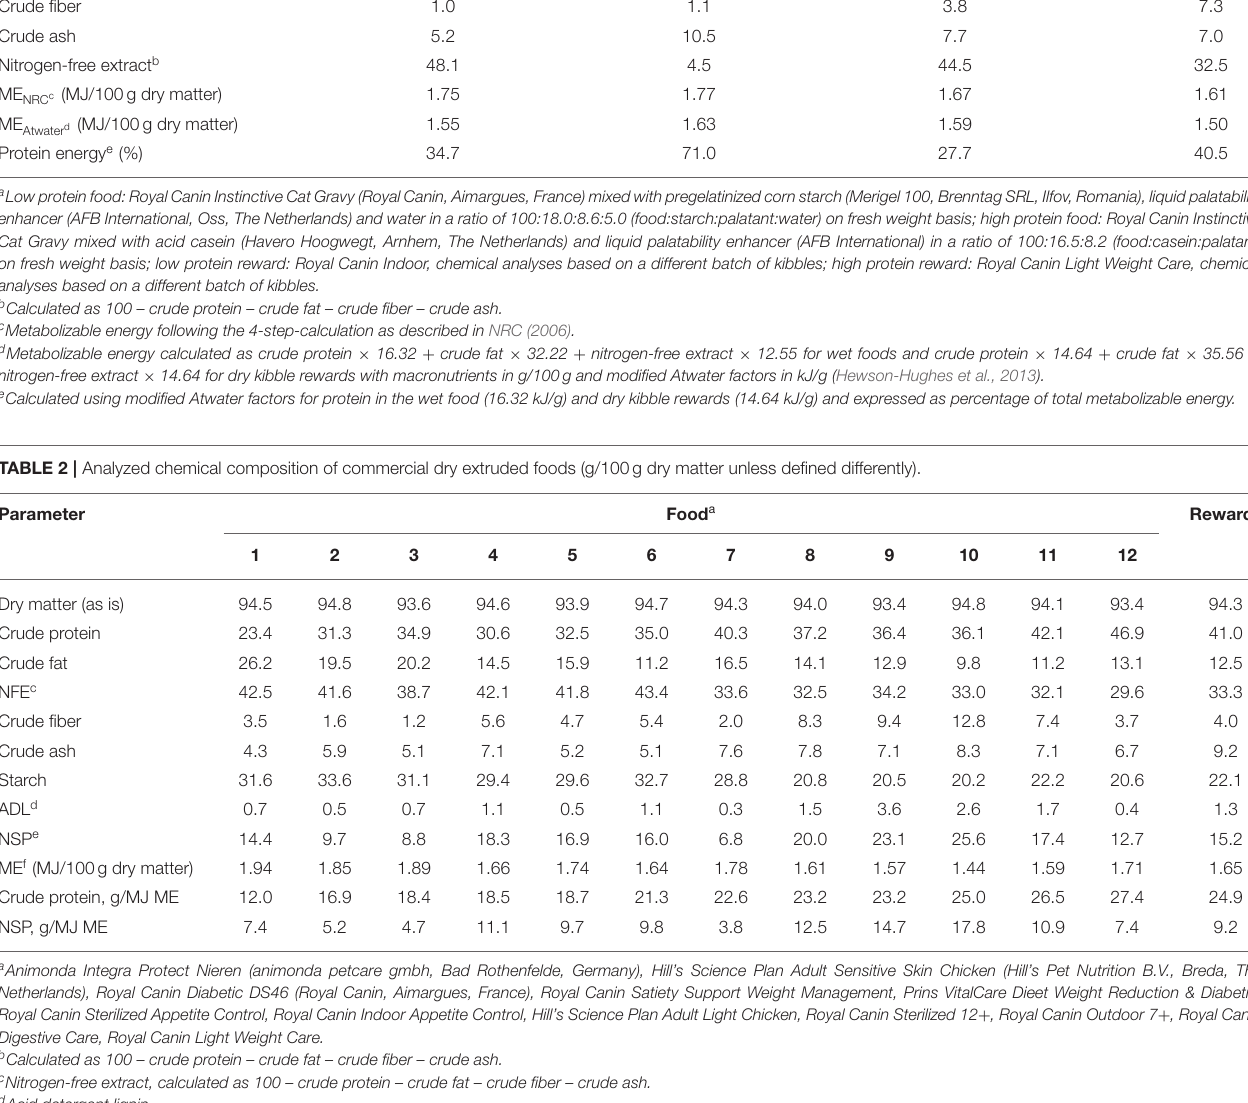
TABLE 1 | Analyzed chemical composition of low and high protein foods and low and high protein kibble rewards a (g/100g dry matter unless defined differently). Parameter Food Reward Low protein High protein Low protein High protein Dry matter (as is) Crude protein Starch